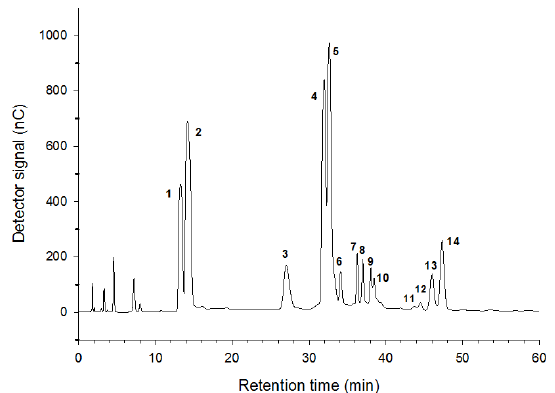
Figure 1. HPAEC-PAD chromatogram of the reaction mixture at 10 h using Bac 55.2 permeabilized cells as a biocatalyst for galactooligosaccharide (GOS)